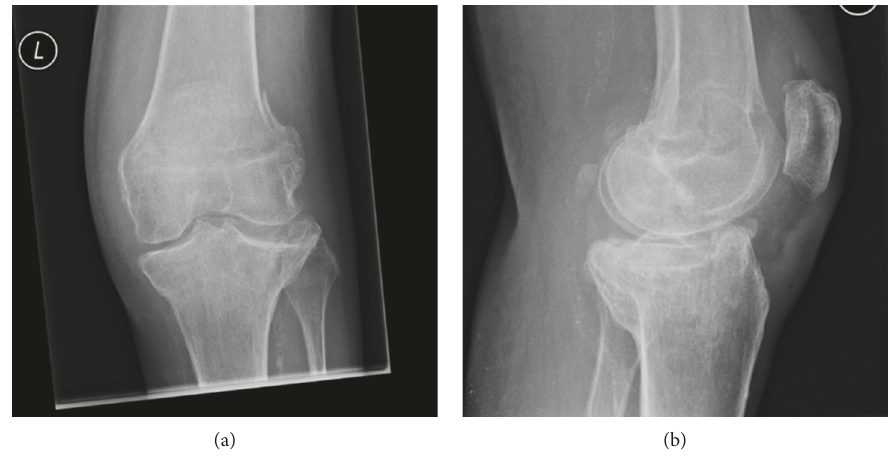
Figure 9: (a) AP and (b) lateral radiographs demonstrating intra-articular femoral and tibial fractures.